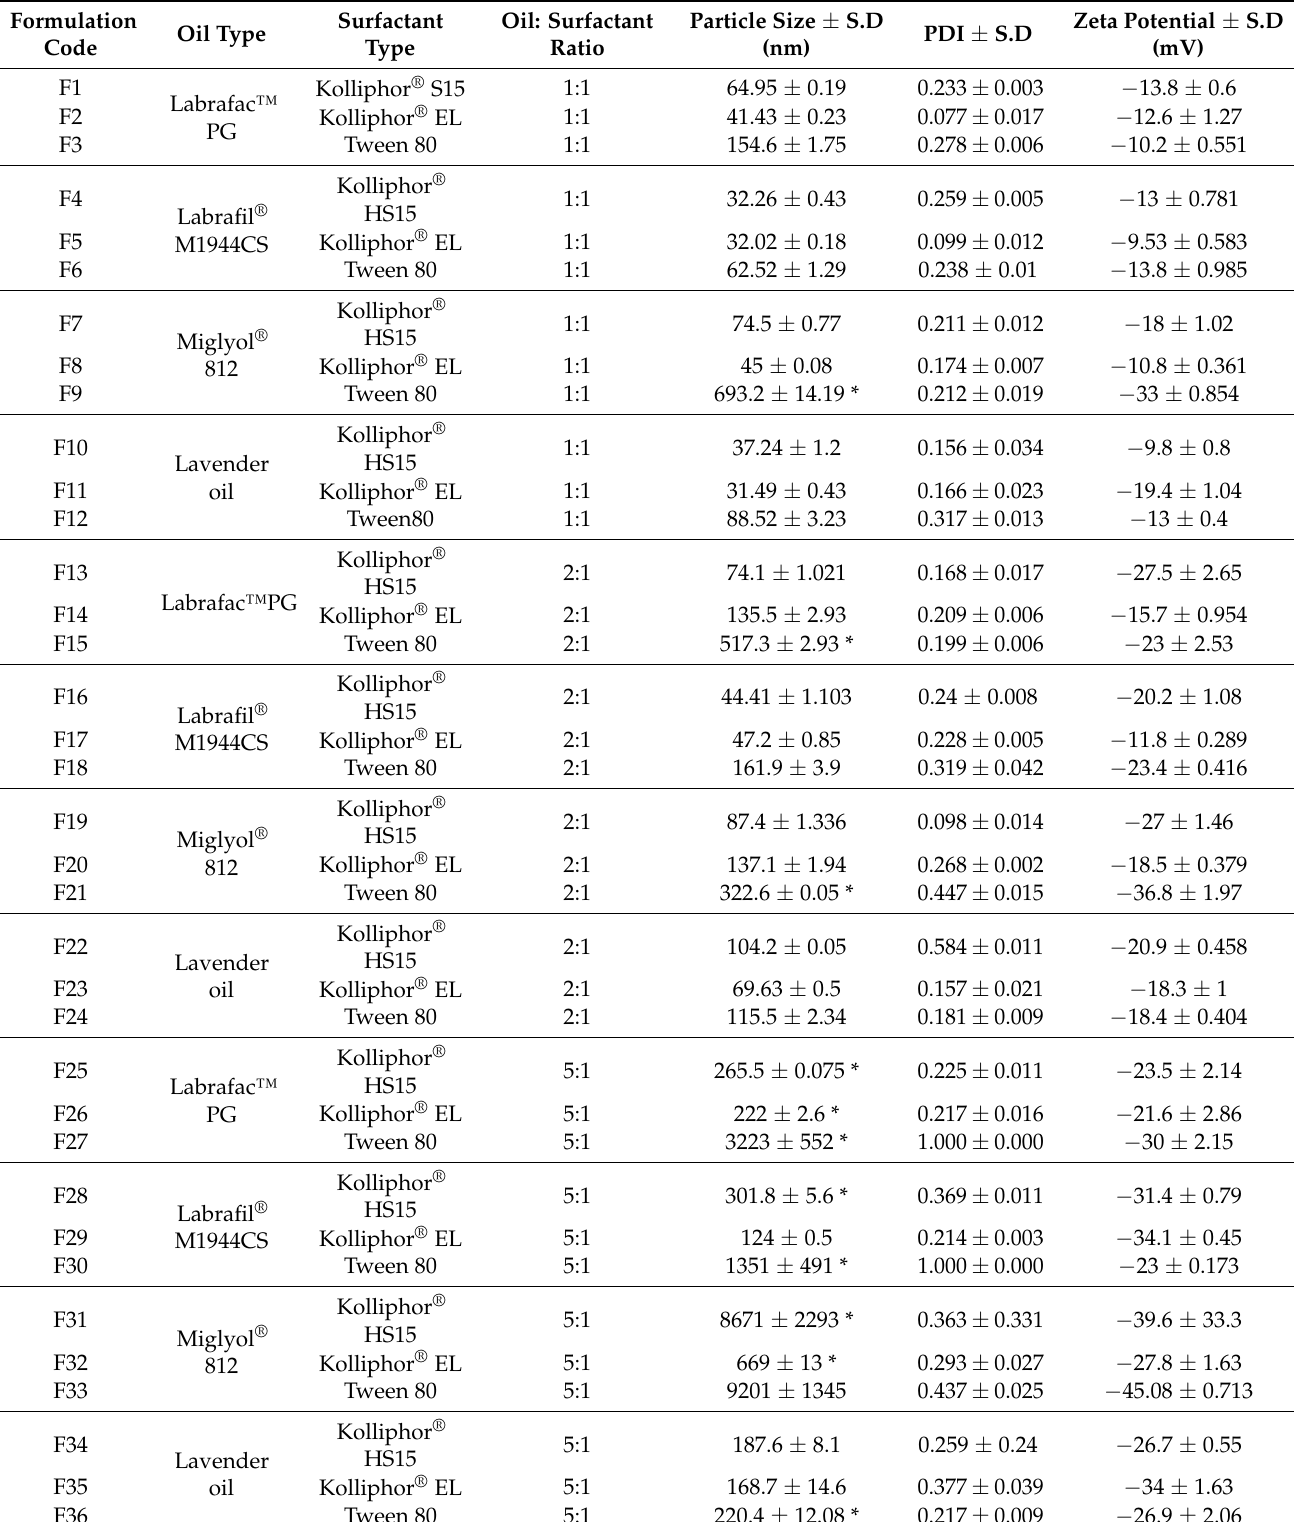
Table 1. Composition of the different blank LNC